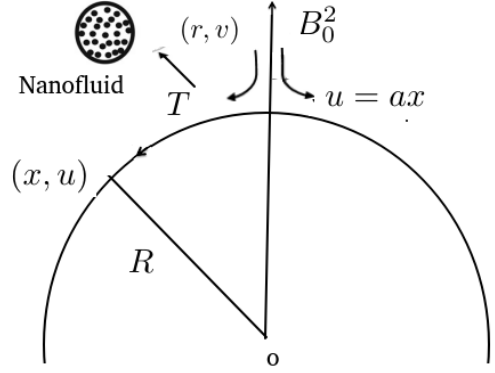
Figure 1. Geometry of the